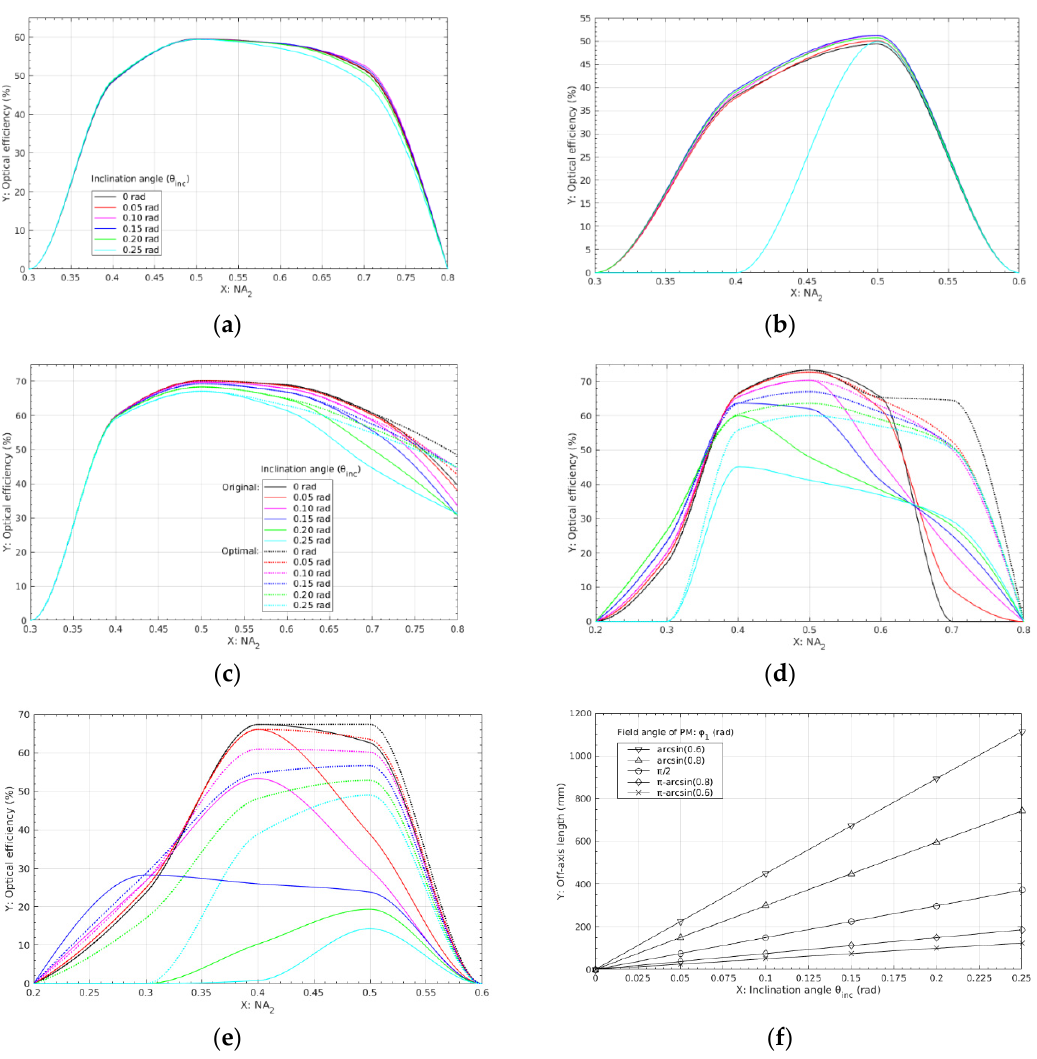
Figure 8. ( a – e ) Results of optical efficiency vs the field angle of the PM (=arcsin 0.6, arcsin 0.8, π /2, π -arcsin 0.8, π -arcsin 0.6 rads) corresponding to original and optimal designs, with C = 3000, D = 6000 mm; ( f ) Off-axis length vs inclination angle in different field angle of PM with D = 6000 mm.